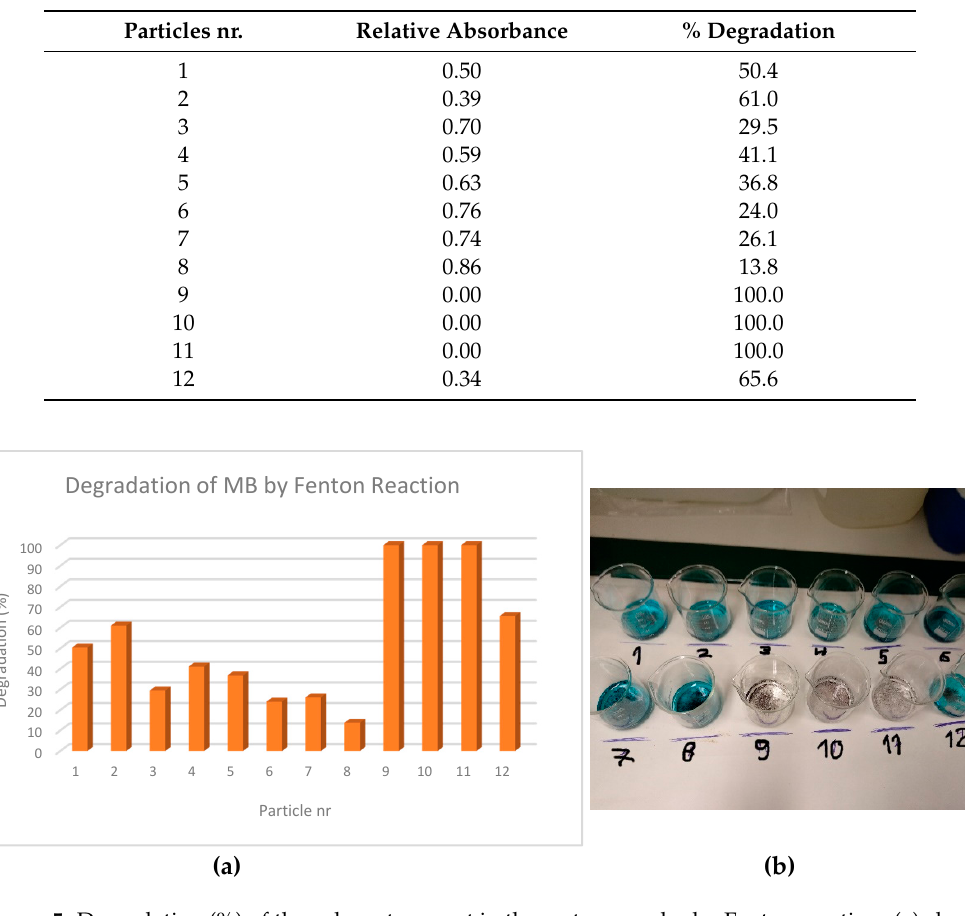
Table 4. Results of the degradation of methylene blue in water by the Fenton process.